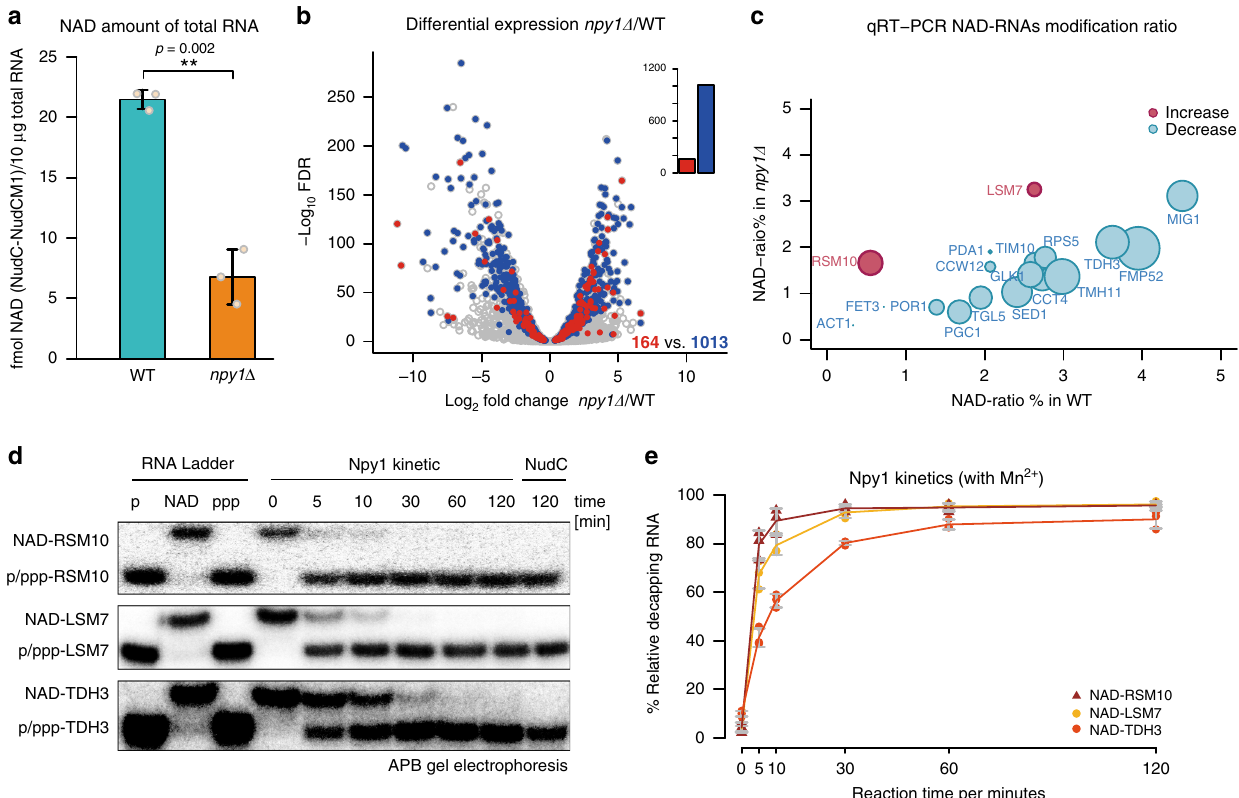
Fig. 4 RNAs are affected differently by Npy1 deletion. a Quanti fi cation of NAD-RNA from total RNA by LC-MS. Integrated NAD content, which was determined via the NR signal intensity (fmol) from washed and NudC-treated total RNA (10 µ g), while subtracting the NR signal intensity obtained from RNA treated with a NudC mutant. Dots represent individual biological triplicate measurements. Error bars represent mean ± SD. Performed in biologically independent replicates, n = 3. p -values are denoted by asterisks: ** p < 0.01 (Student ’ s t -test, one-sided). b Volcano plot of transcripts comparing WT with npy1 Δ samples by RNA expression level and NAD-modi fi cation ratio. The log 2 fold change of transcript abundance from transcriptome sequencing ( npy1 Δ vs. WT) is plotted versus the log 10 false discovery rate (FDR). Different transcripts (7620) were analyzed and represented as dots. Red dots